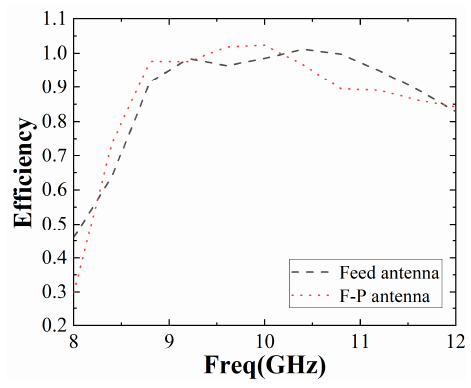
Figure 16. Efficiency of antenna.